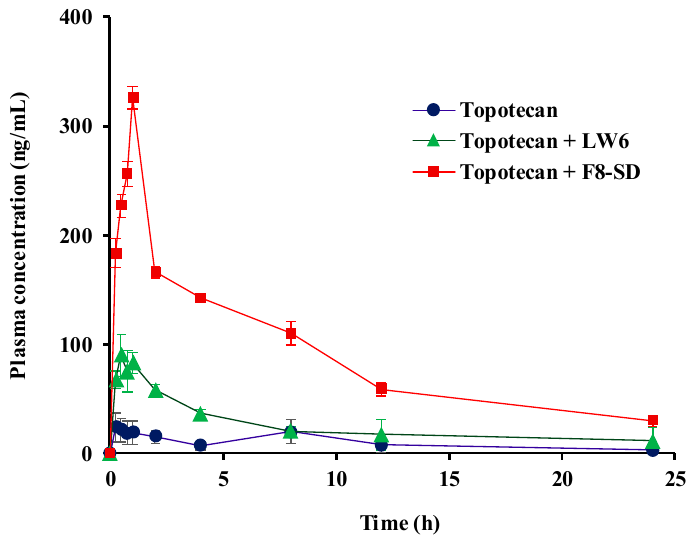
Figure 11. Plasma concentration–time profiles of topotecan following the oral administration of topotecan (10 mg/kg) to rats in the presence or absence of LW6 (20 mg/kg) in different formulations. Data are expressed as the mean ± standard deviation (n = 3).